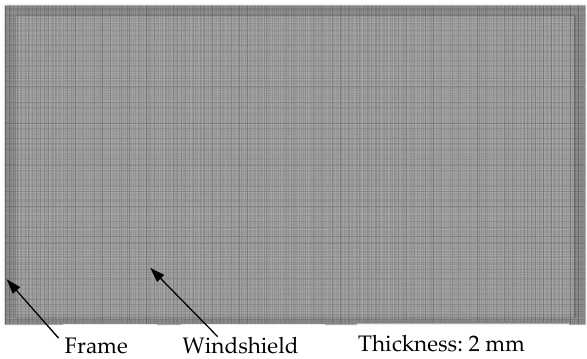
Figure A2. Schematic diagram of the simplified finite element windshield model.